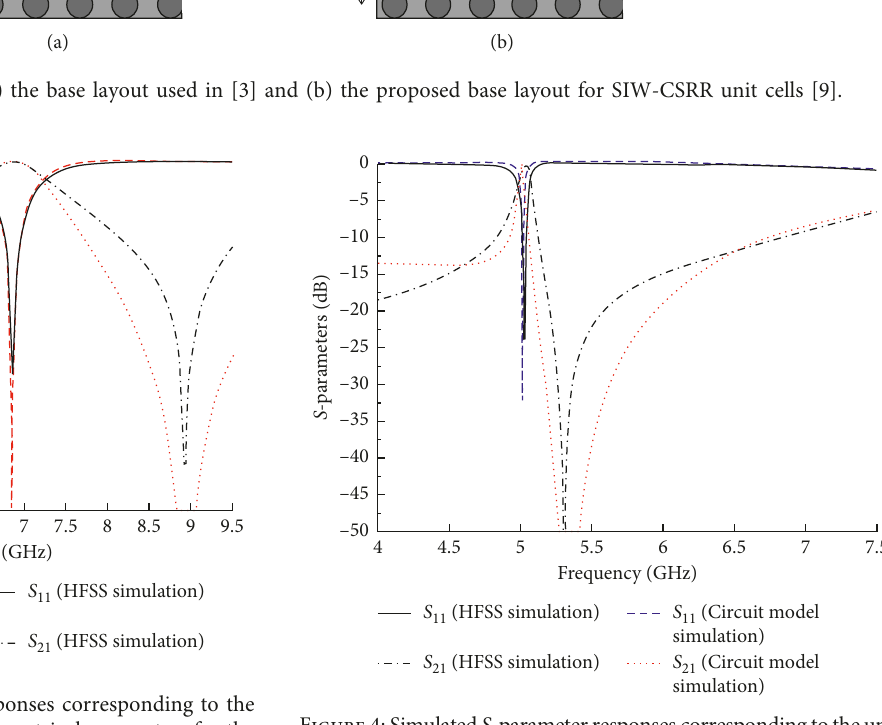
Figure 4: Simulated S -parameter responses correspondingto theunit cell shown in Figure 2(b). The geometrical parameters for the unit cells are w � 12.3mm, L � 2mm, g � 0.18mm, a 1 � 3.92mm, a 2 � 3.92mm, a 3 � 2mm, a 4 � 1.2mm, and a 5 � 3.2mm. The electrical parameters of the equivalent circuit models in this case are L d � 1.9nH, L c � 1.15nH, C c � 0.78pF, L r � 1.25nH, and C r � 1pF